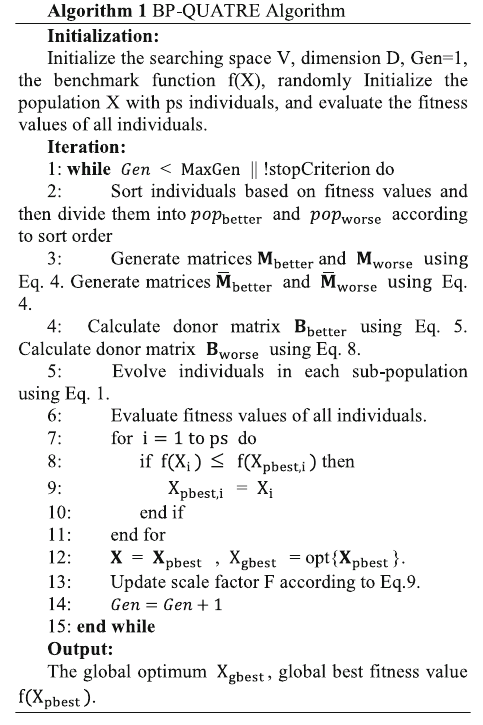
The pseudo code of BP-QUATRE algorithm is shown in Algorithm